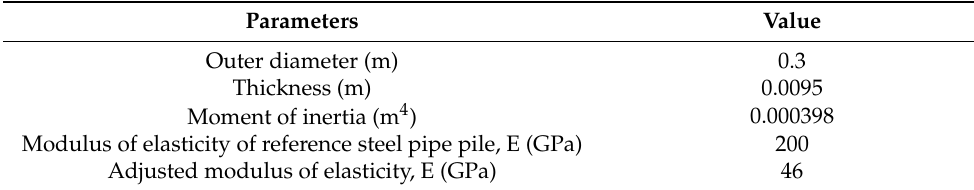
Table 4. Properties of steel